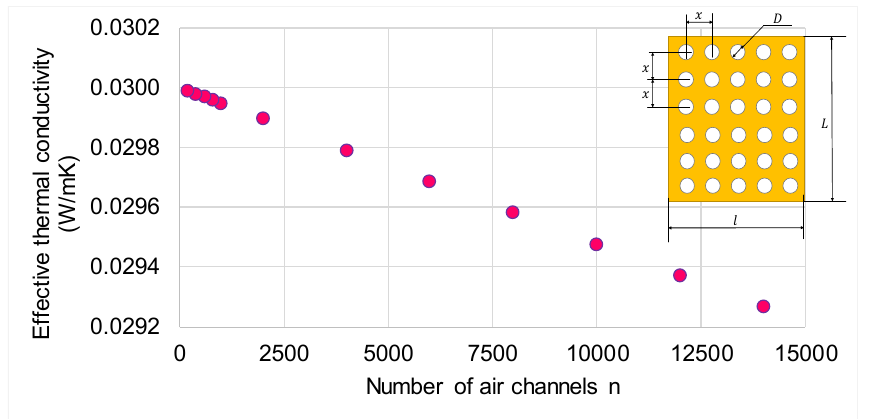
Figure 7. Variation of calculated effective thermal conductivity of the perforated panel as a function of the number of channels.